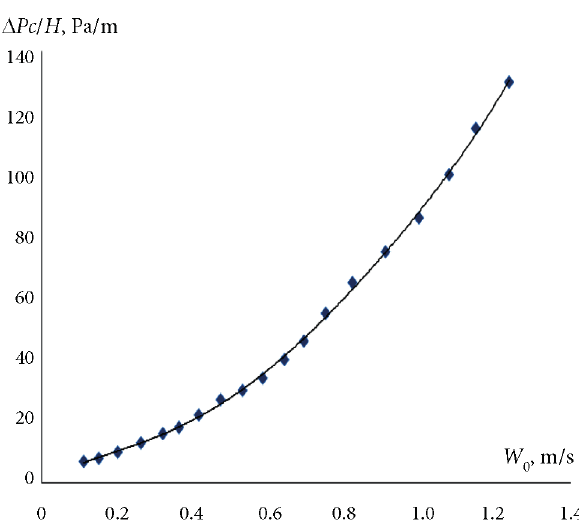
/H on the flow c